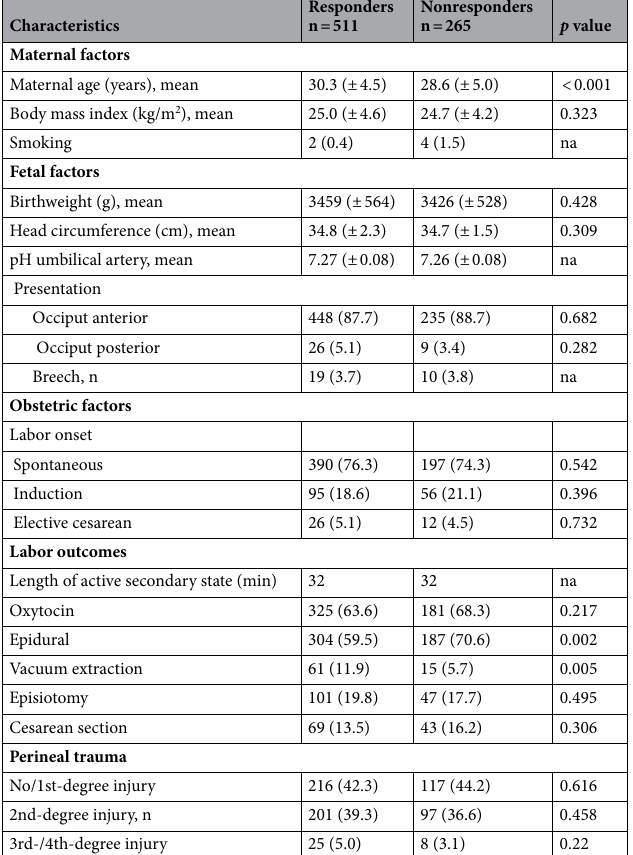
Table 1. Demographic and obstetric characteristics of the study population. Data are presented as the mean ± standard deviation (SD) or n (%). * na = not